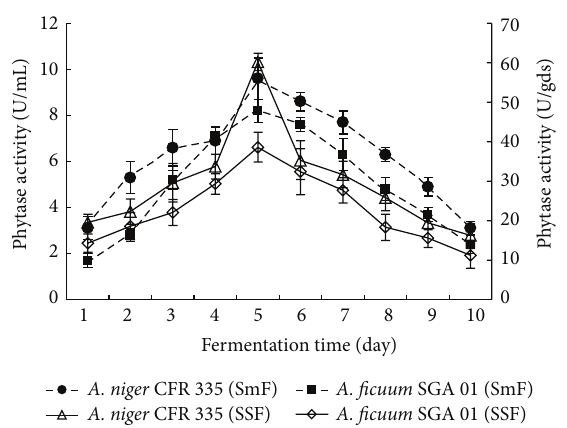
Figure 6: Effect of fermentation time on phytase production by As- pergillus niger CFR 335 and Aspergillus ficuum SGA 01 in submerged and solid-state fermentation.